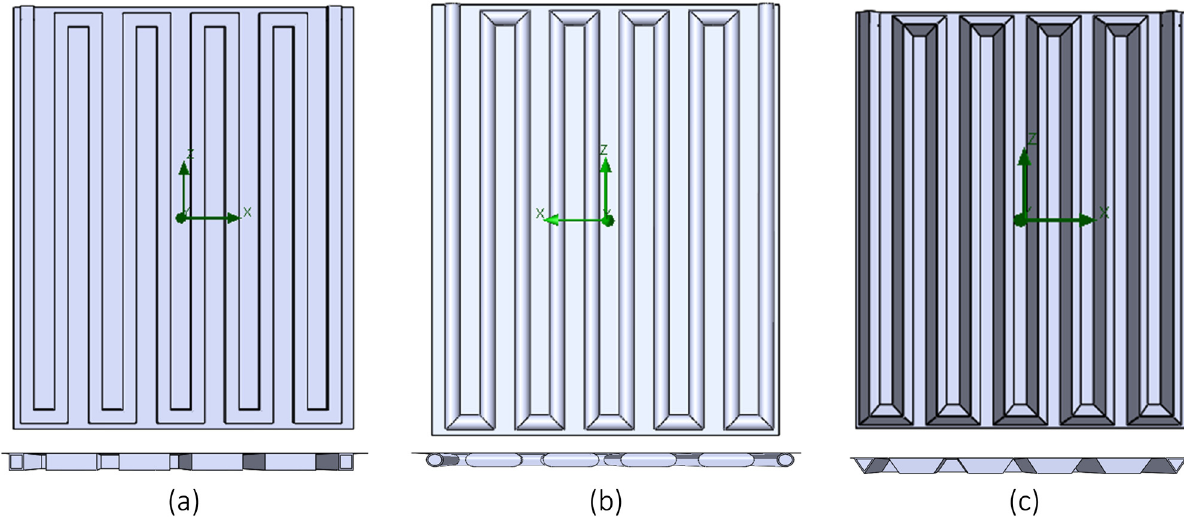
Figure 3: Thermal con fi guration of collector: ( a ) square box, ( b ) pipe box, and ( c ) triangular box.